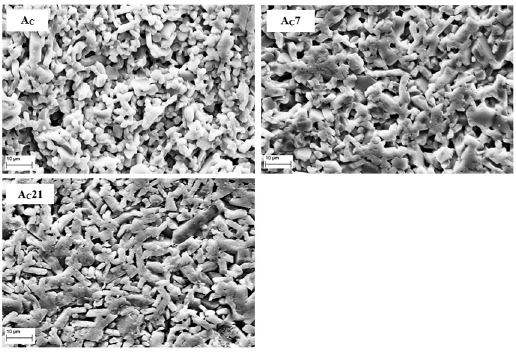
(1,600 ºC/10 h, d C = 0.96) and A rel